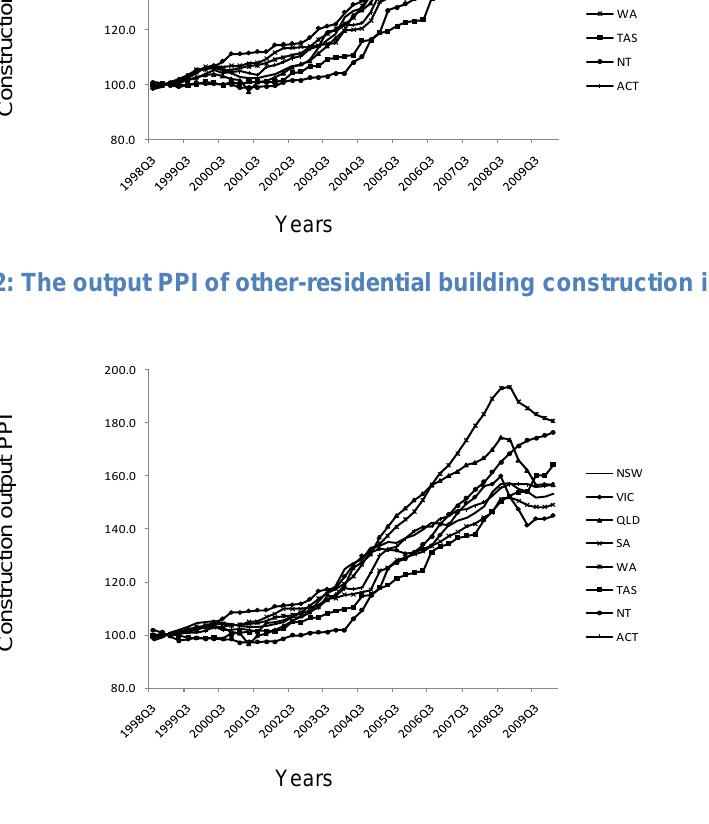
Figure 3: The output PPI of non-residential building construction in